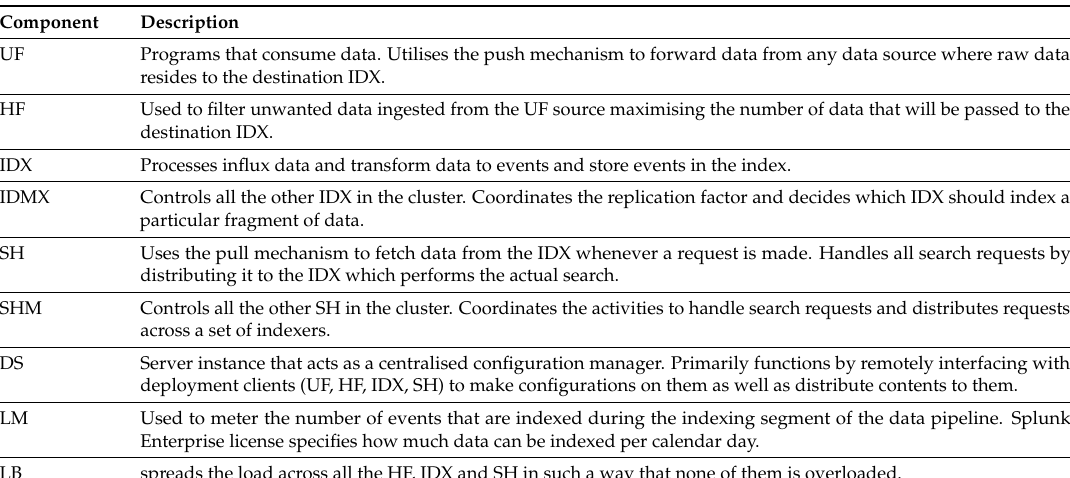
Table 1. Description of splunk